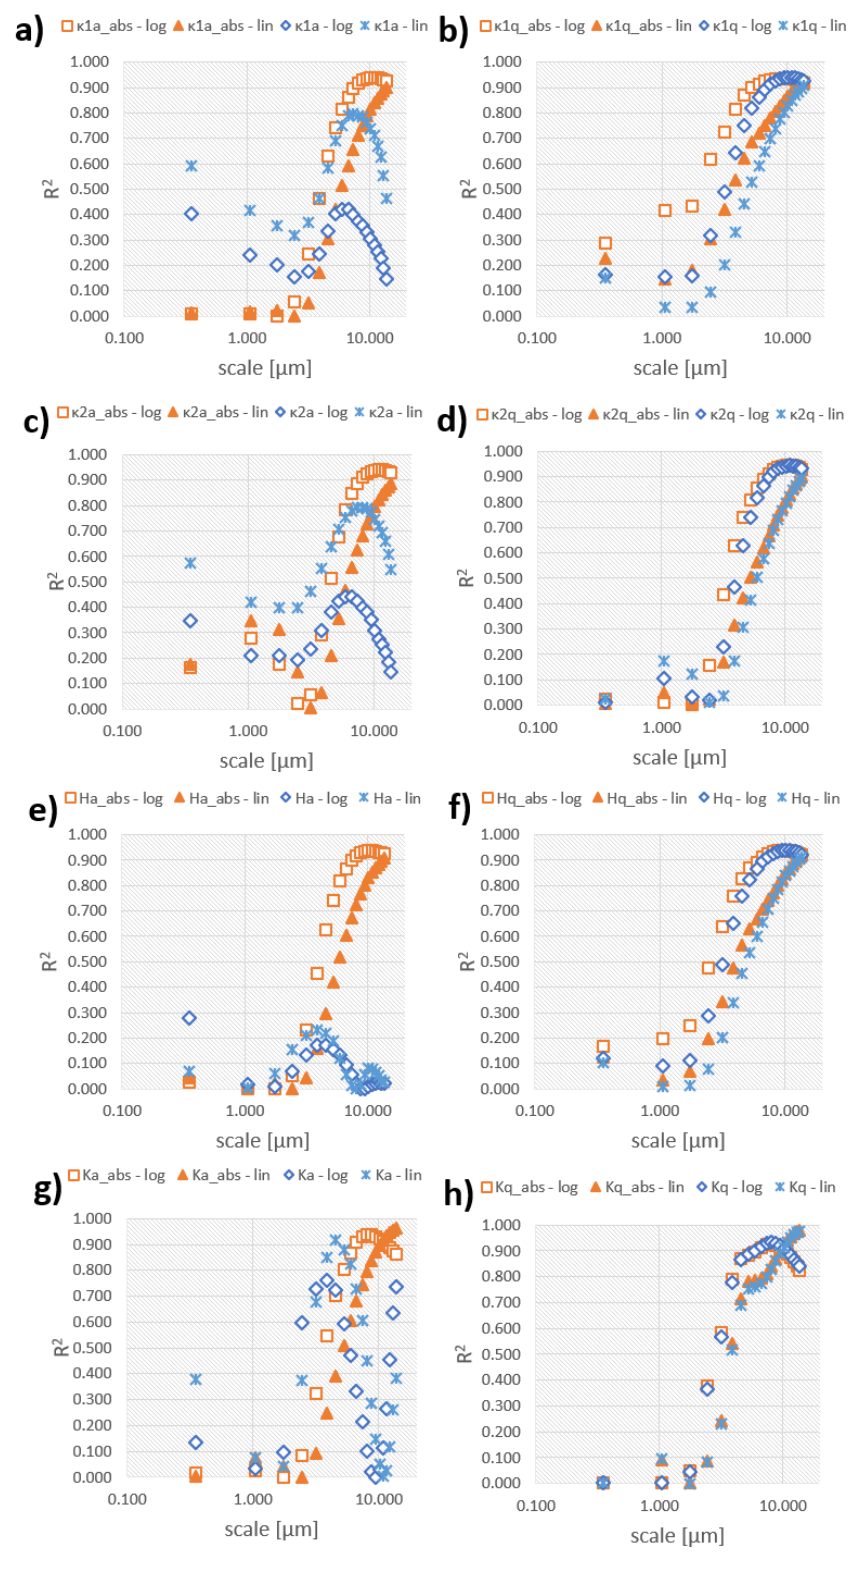
Figure 11. Coefficient of determination for linear and logarithmic regression calculated for statistical parameters calculated for: ( a ) average maximum; ( b ) standard deviation of maximum; ( c ) minimum and ( d ) standard deviation of minimum curvature versus discharge energy; ( e ) average mean curvature; ( f ) standard deviation of mean curvature; ( g ) average Gaussian curvature and ( h ) standard deviation of Gaussian curvature as a function of scale.